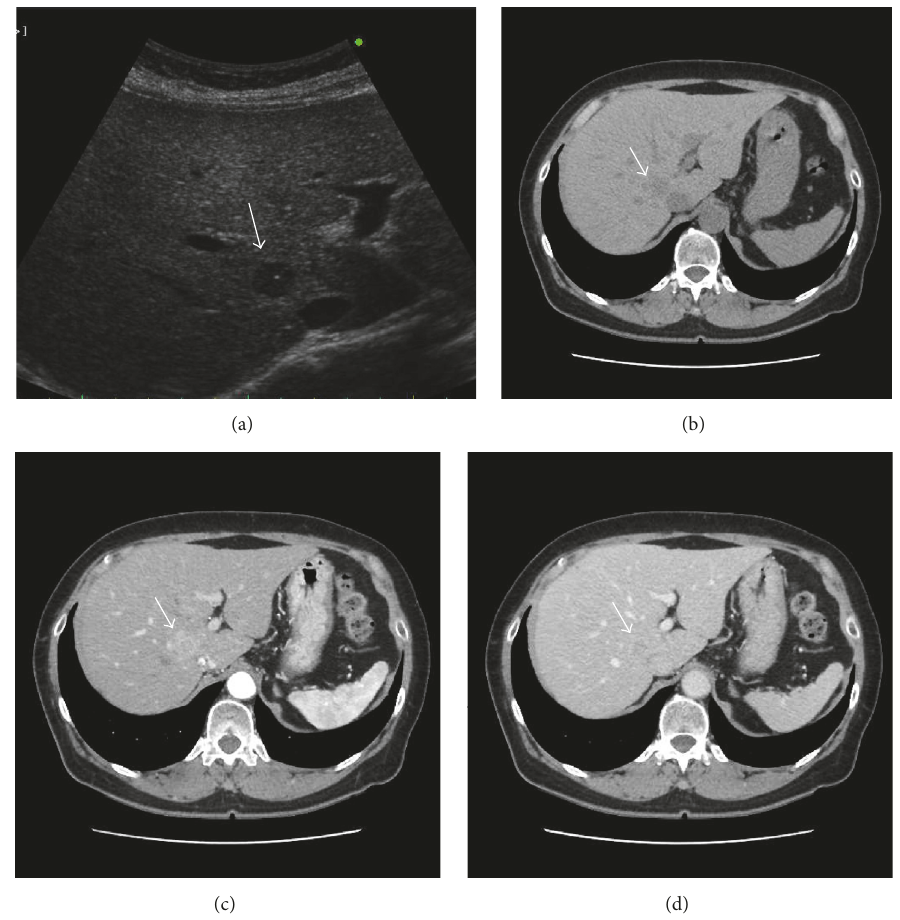
Figure 1: Ultrasonography and computed tomography. US revealed a 14 × 10mm well-defined, hypoechoic mass (arrow) in the posterosuperior subsegment of the right hepatic lobe (segment 7) (a). Plain CT shows a low-density mass at the right hepatic lobe (arrow) (b). The tumor was enhanced in the arterial phase (c) and washed out in the portal phase (d).